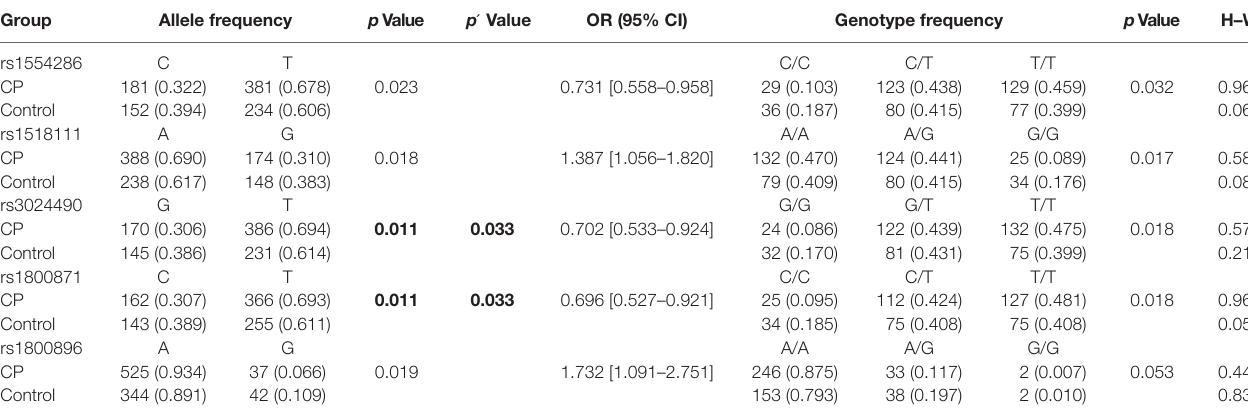
TaBle 3 | Allele and genotype frequencies of IL-10 in total cerebral palsy (CP) patients and controls. group allele